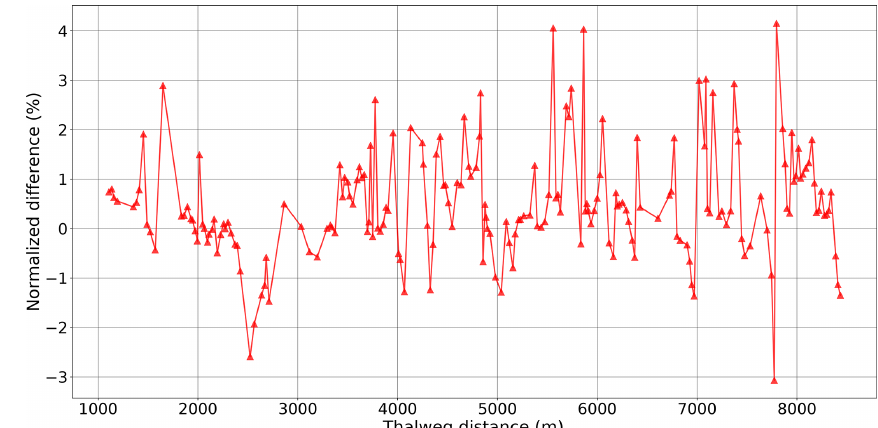
Figure 17. Normalized difference ρ(x) between SPRNT-RS and unsteady HEC-RAS.